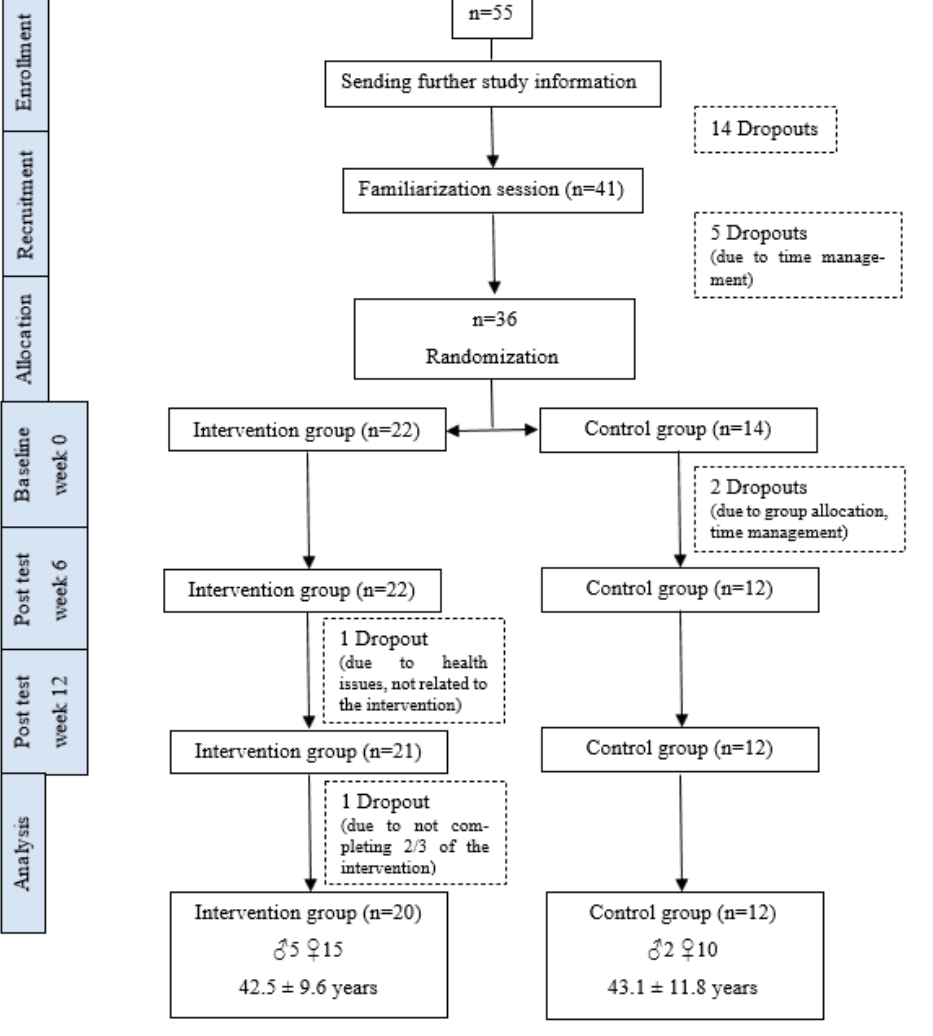
Figure 1. Flow diagram of participants.